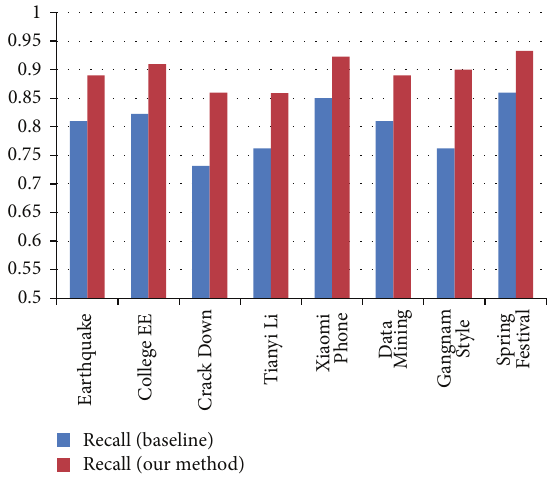
Figure 4: Comparison of Precision measure between baseline and our methods. Figure 5: Comparison of Recall measure between baseline and our